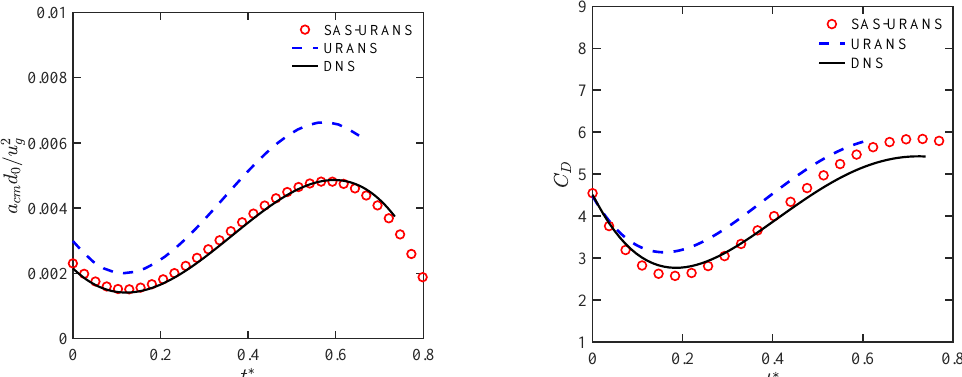
Figure 6. Normalized displacement ( left ) and velocity ( right ) of the droplet CM for SAS-URANS, URANS [19], and DNS [15].